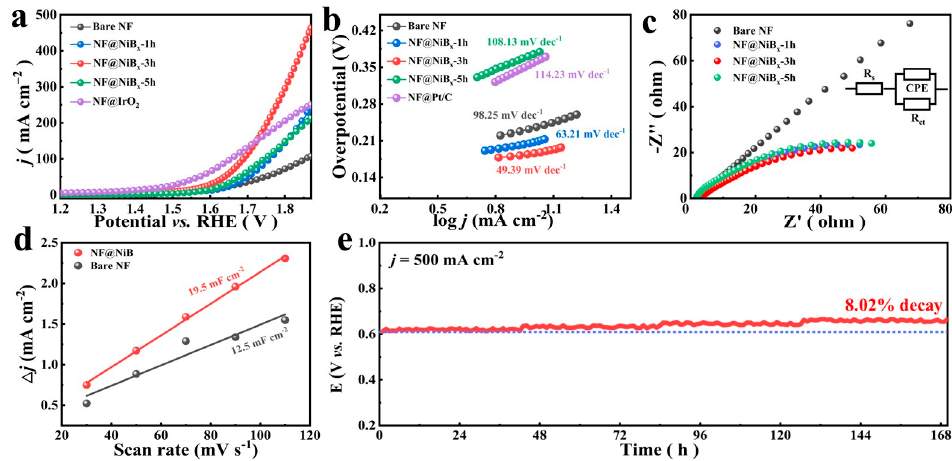
Figure 3. OER performance in 1 M KOH + 0.5 M NaCl solution: ( a ) LSV curves; ( b ) Tafel slopes; ( c ) Nyquist plots; ( d ) C dl values; ( e ) Chronopotentiometric measurement of OER at the current density of 200 mA·cm − 2 .